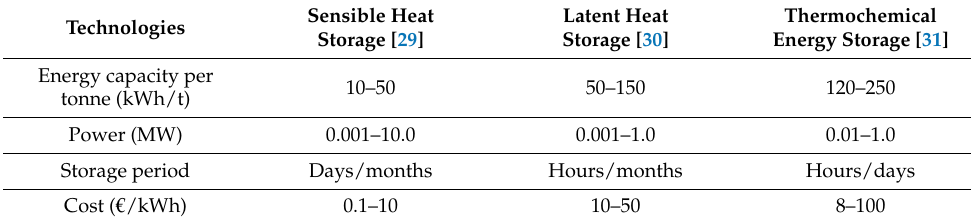
Table 1. Comparison of the three prominent types of thermal energy storage systems